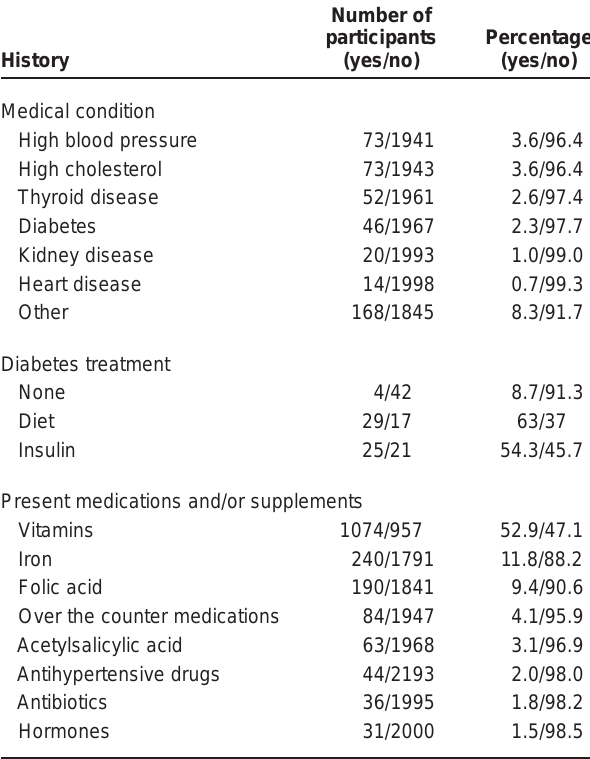
TABLE 1 Demographic characteristics of participants in the Edmonton Perinatal Study